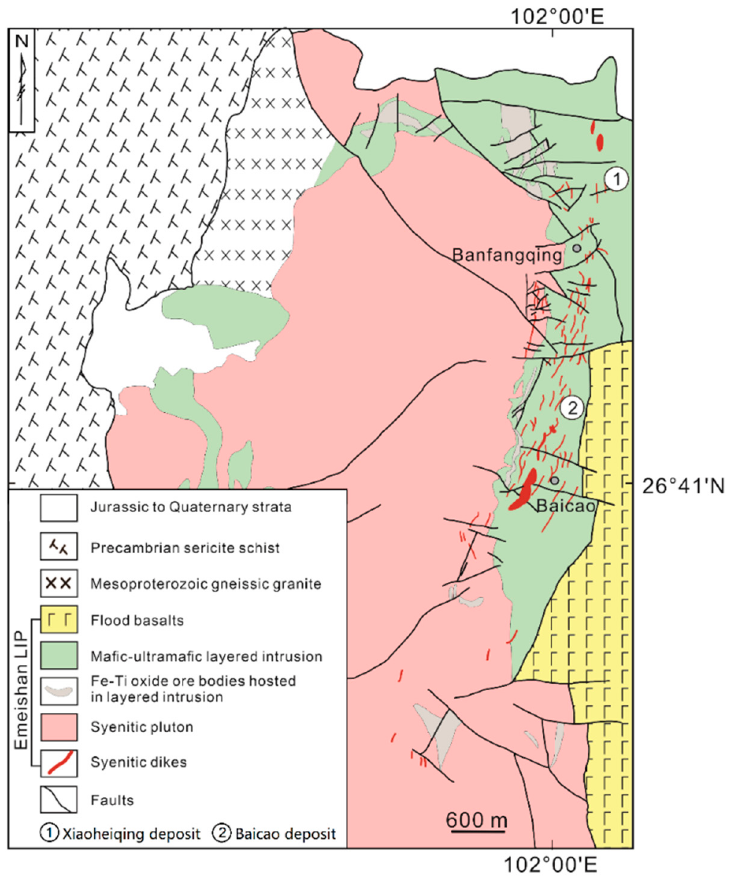
Figure 3. Simplified geologic map showing the syenitic dikes and syenitic pluton in the Baicao and Xiaoheiqing deposits. Modified after [54,55].